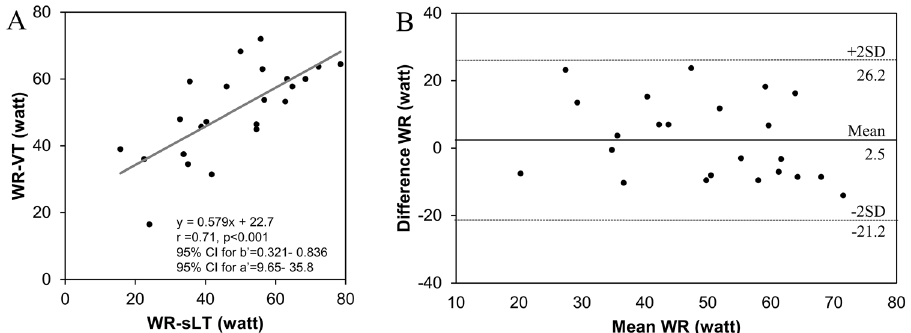
Figure 4. Validity testing of the WR at the sLT and bLT or VT1. ( A ) The graph shows the relationship between the work rate (WR) at the lactate threshold in sweat (WR-sLT) and WR-ventricular threshold (WR-VT1). ( B ) The graph shows the Bland–Altman plots, which indicate the respective differences between WR-sLT, and WR-VT1 (y-axis) for each individual against the mean of WR-sLT, and WR-VT1 (x-axis). r correlation coefficient, 95% CI for b’ 95% confidence interval for the slope, 95% CI for a’ 95% confidence interval for y-intercept, SD standard